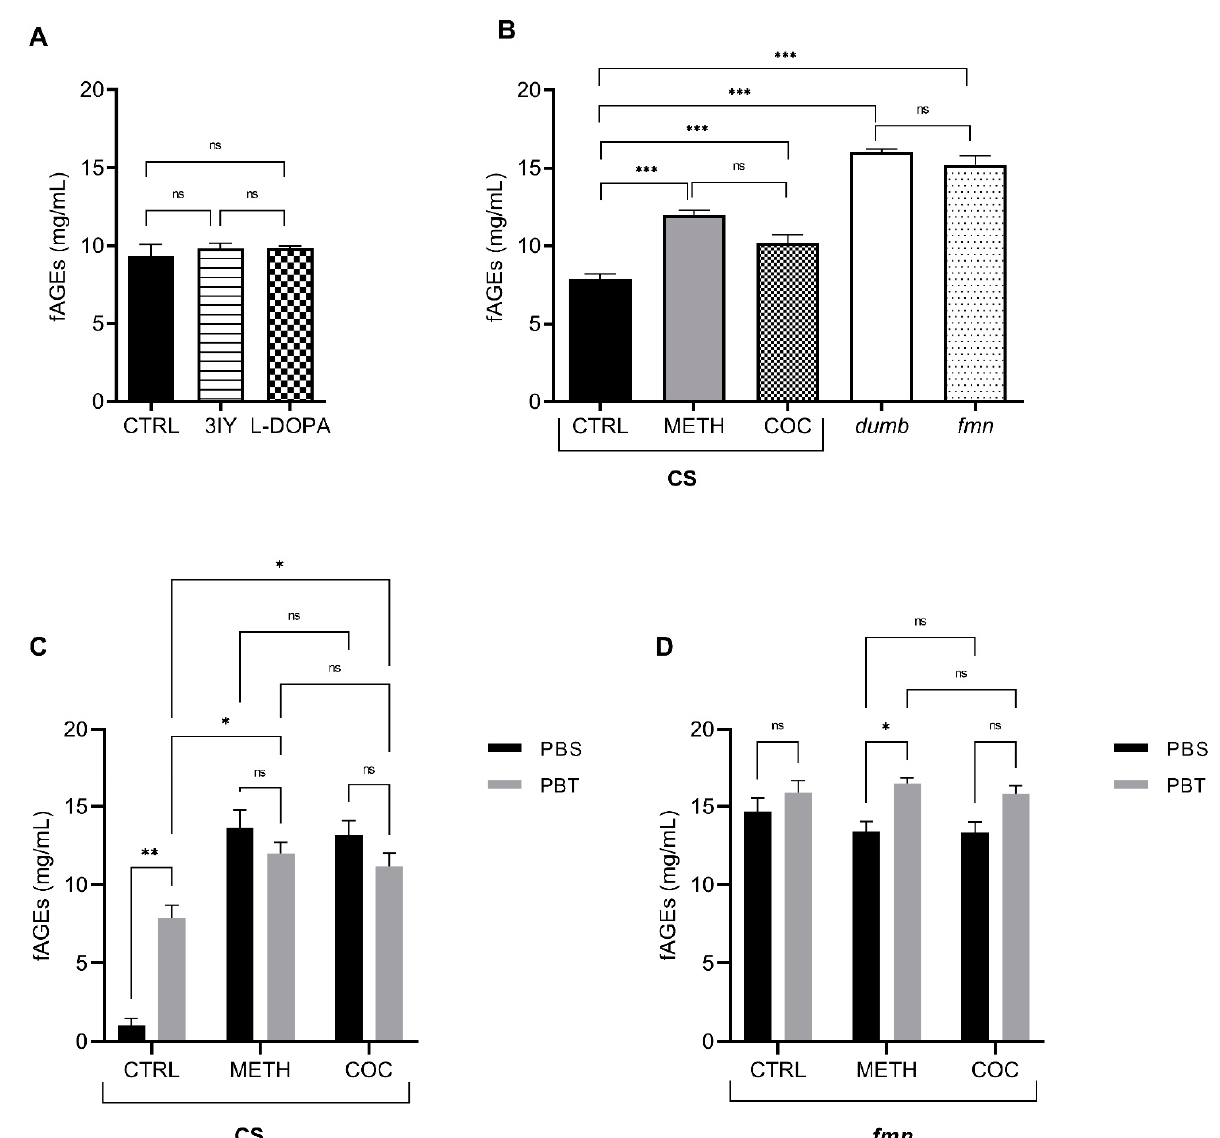
Figure 3. The amount of fAGEs formation depends on the type, duration and location of DA signaling manipulation. ( A ) fAGEs concentration in wt male whole body extracts prepared using PBT protocol: no treatment (CTRL), 48 h of feeding with 5 mg/mL 3-iodotyrosine (3IY) or 1 mg/mL L-3,4-dihydroxyphenylalanine (L-DOPA) ( n = 5 flies for each condition, in triplicates; one-way ANOVA with Bonferroni post hoc tests, non-significant (ns)). ( B ) fAGEs concentration in male wt (CS), dumb and fmn whole body extracts using PBT protocol: CTRL wt flies without treatment, wt flies fed 0.5 mg/mL METH or COC for 48 h ( n = 5 flies for each condition, in triplicates, one-way ANOVA with Bonferroni post hoc tests). Significant values: ***: p < 0.001 and non-significant (ns). ( C ) fAGEs concentration determined in whole body extracts using PBS and PBT protocols in CantonS wt male flies (CS): no treatment (CTRL) and fed for 48 h with 0.5 mg/mL METH or COC ( n = 5 flies for each conditions, in triplicates, two-way ANOVA with Bonferroni post hoc tests). Significant values: *: p < 0.05, **: p < 0.01 and non-significant (ns). ( D ) fAGEs concentration determined in whole body extracts using PBS and PBT protocols in fmn mutant flies: no treatment (CTRL) and fed for 48 h with 0,5 mg/mL METH or COC ( n = 5 flies for each conditions, in triplicates, two-way ANOVA with Bonferroni post hoc tests). Significant values: *: p < 0.05 and non-significant (ns).